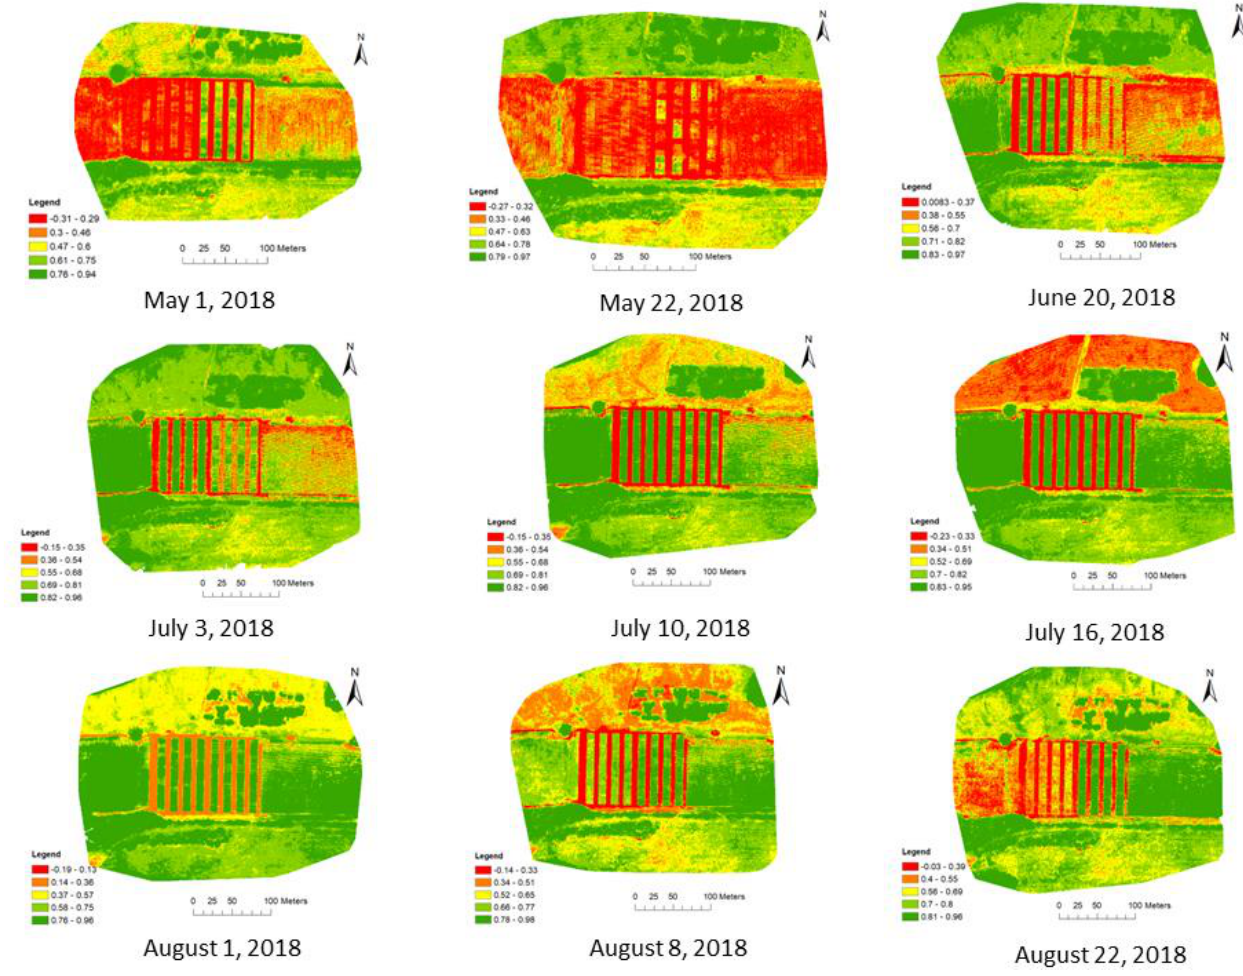
Figure 9. UAV NDVI images of the soybean field in the research farm area at Pontotoc, Mississippi in 2018.